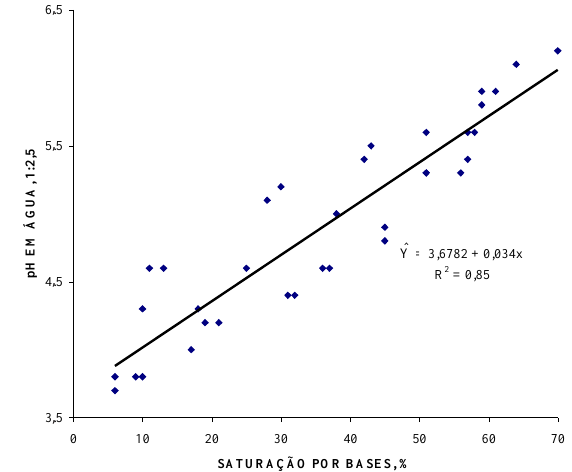
Figura 3. Relação entre o pH em água (1:2,5) e a saturação por bases de um solo Glei Pouco Húmico, com quatro cultivos de milho e três de soja em sucessão. Dados de 35 pares, médias de quatro